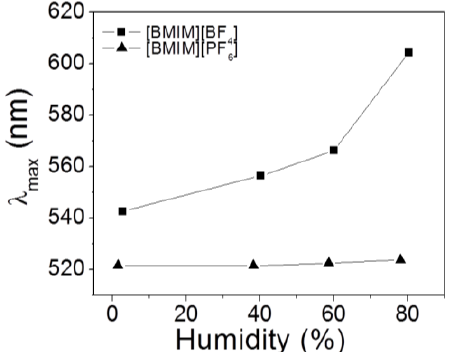
Figure 6. Comparison of wavelength shifts for 2.5%-crosslinked PHEMA IOPG soaked in two different ILs of [BMIM + ][BF 4− ] and [BMIM + ][PF 6− ] with respect to humidity change.